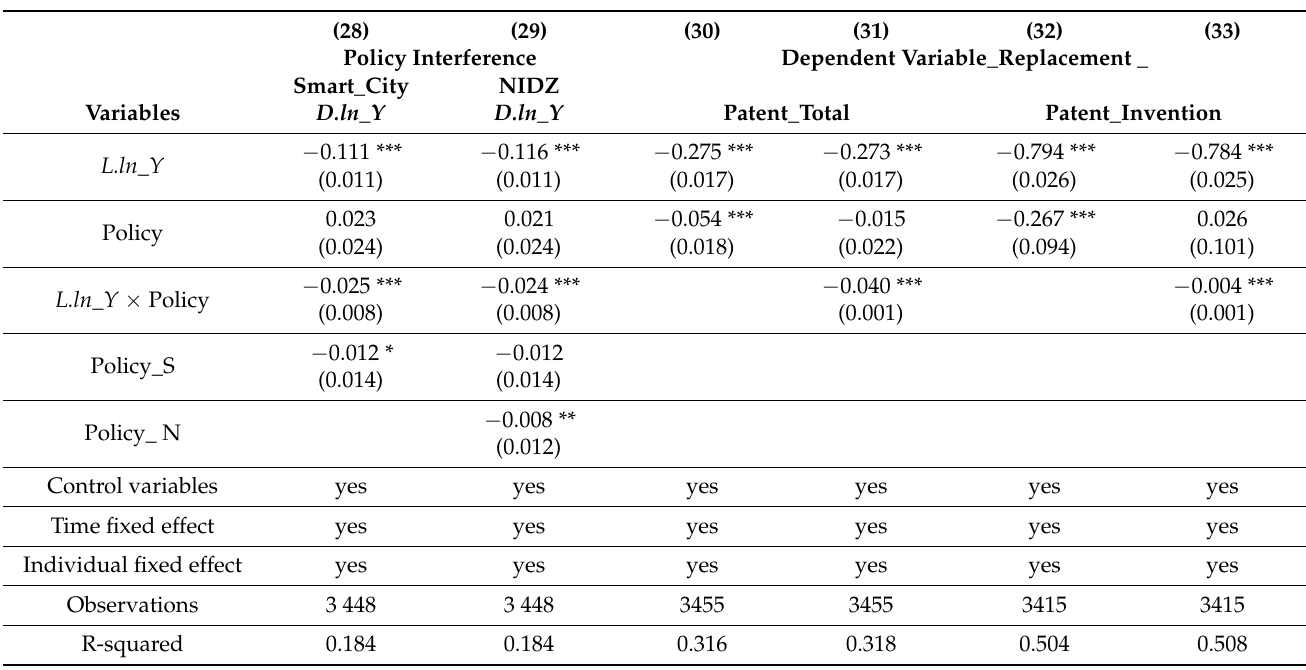
Table 6. Robustness test.